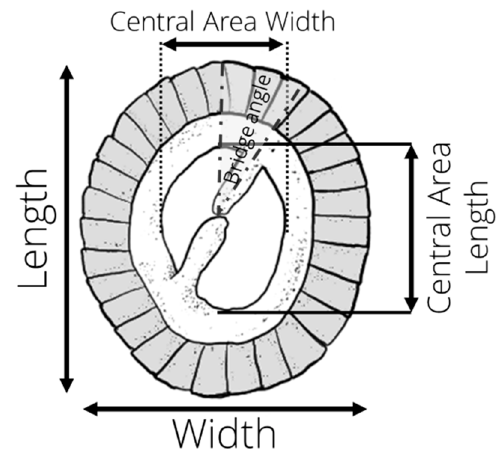
Figure 3. Measurements done on digitized photos of Gephyrocapsa placoliths under phase contrast research microscope at 1000× magnification.